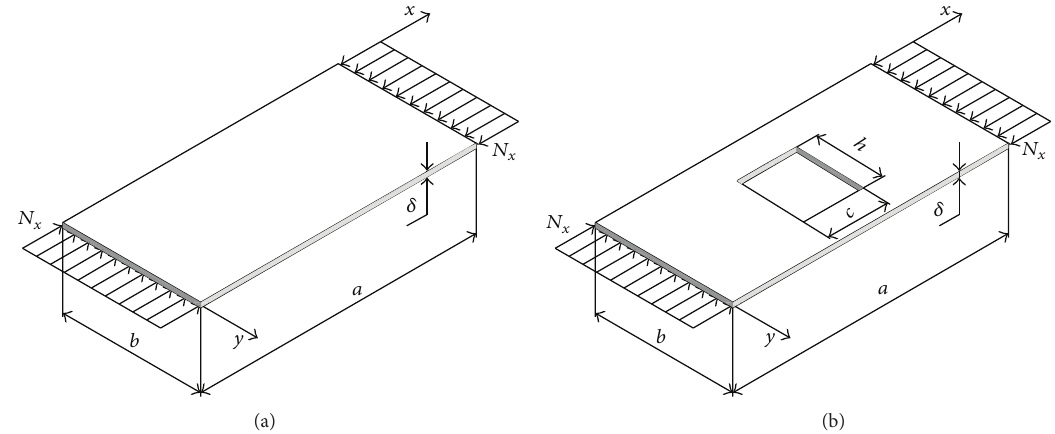
Figure 3: Uniaxial stressed rectangular plate: (a) uniform geometry; (b) with a rectangular hole.